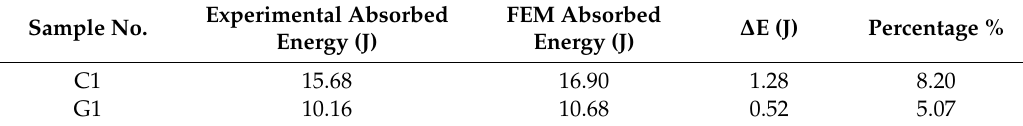
Table 9. Comparison between the experimental and FE measurement for the absorbed energies. Sample No.